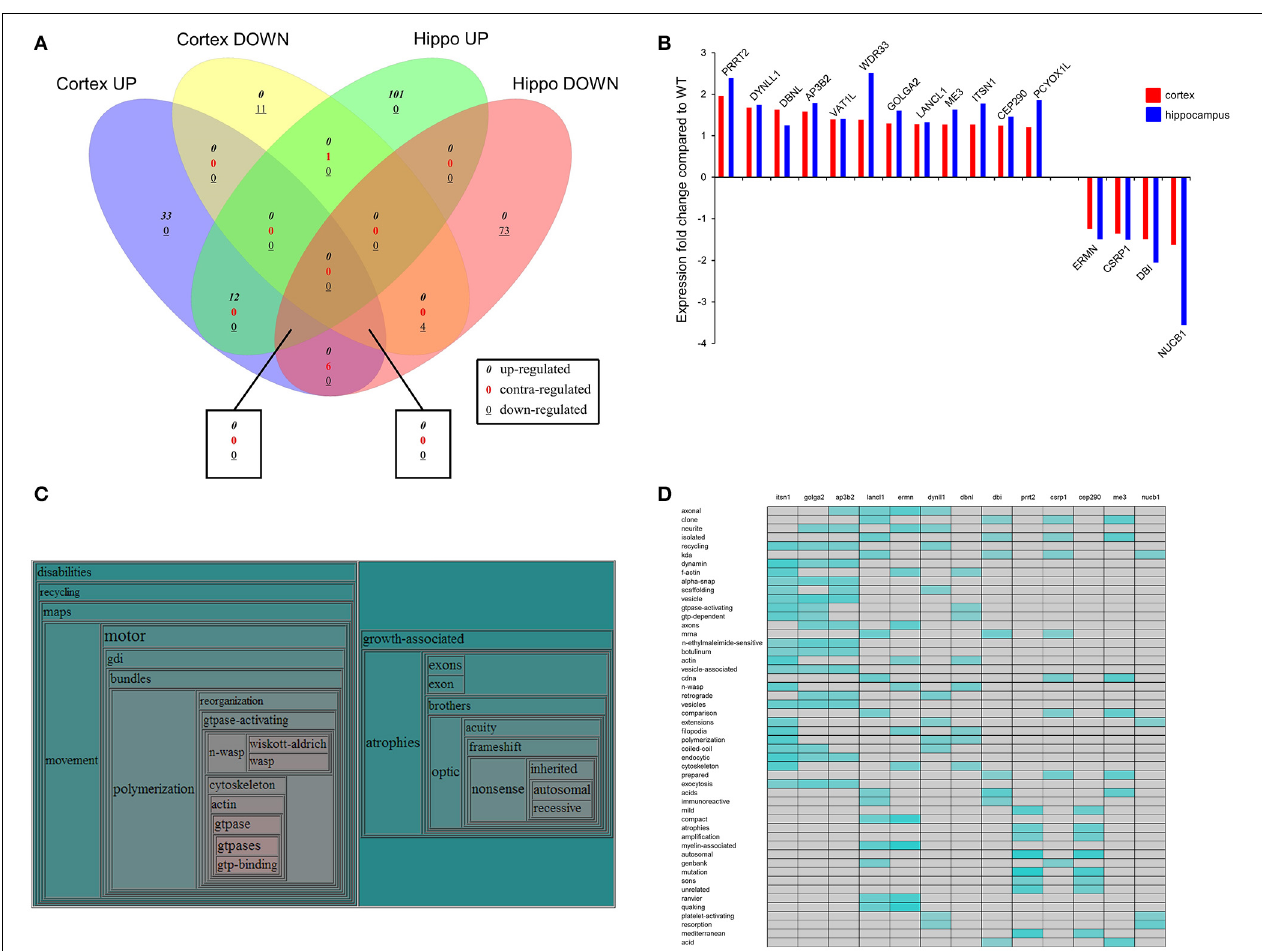
FIGURE 6 | Identification of coherent regulatory protein signatures in BTBR CNS tissues. Vennplex diagram analysis of the upregulated (BTBR:WT iTRAQ ratio > 1.2) or downregulated (iTRAQ ratio < 0.8) proteins in both the hippocampus and cortex are depicted (A) . A small coherently-regulated protein subset across both tissues was evident and comprised a focused protein set strongly linked to human ASD-like conditions (B) . Textrous!- based